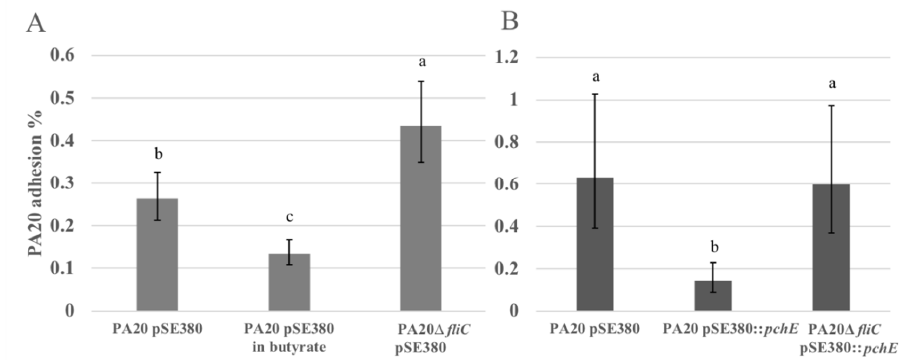
Figure 7. PA20 adhesion to cultured HEp-2 cells. ( A ) The effect of fliC and 20 mM sodium butyrate on PA20 adhesion to HEp-2 cells. ( B ) The role of fliC in pchE- induced repression of PA20 adhesion to HEp-2 cells. The calculated mean percentage values (and 95% confidence levels) of the adhered strains were determined following 3 h exposure to HEp-2 cells in EMEM at 37 °C in 5% CO 2 . Three independent samples ( A ) and four independent samples ( B ) were tested in two separate trials. Any two treatment means with no letter in common are significantly different ( p < 0.05).